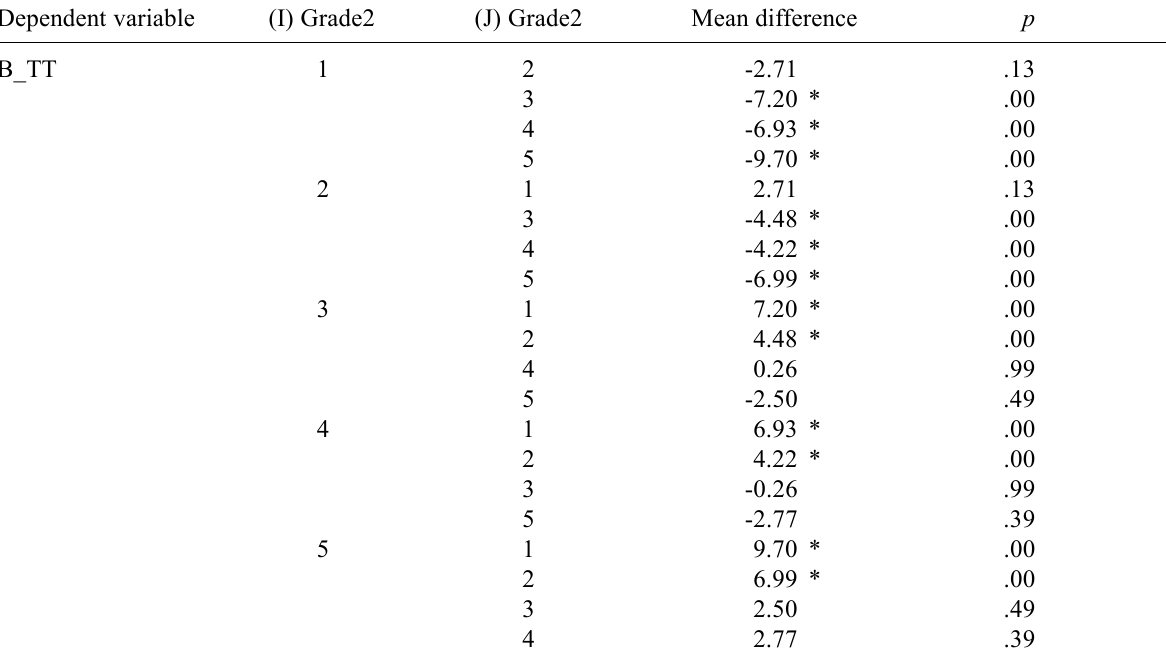
Table 5 Differences in Mean Verified by Tukey Analysis between Each Evaluated Grade for the Total Score of Form B Dependent